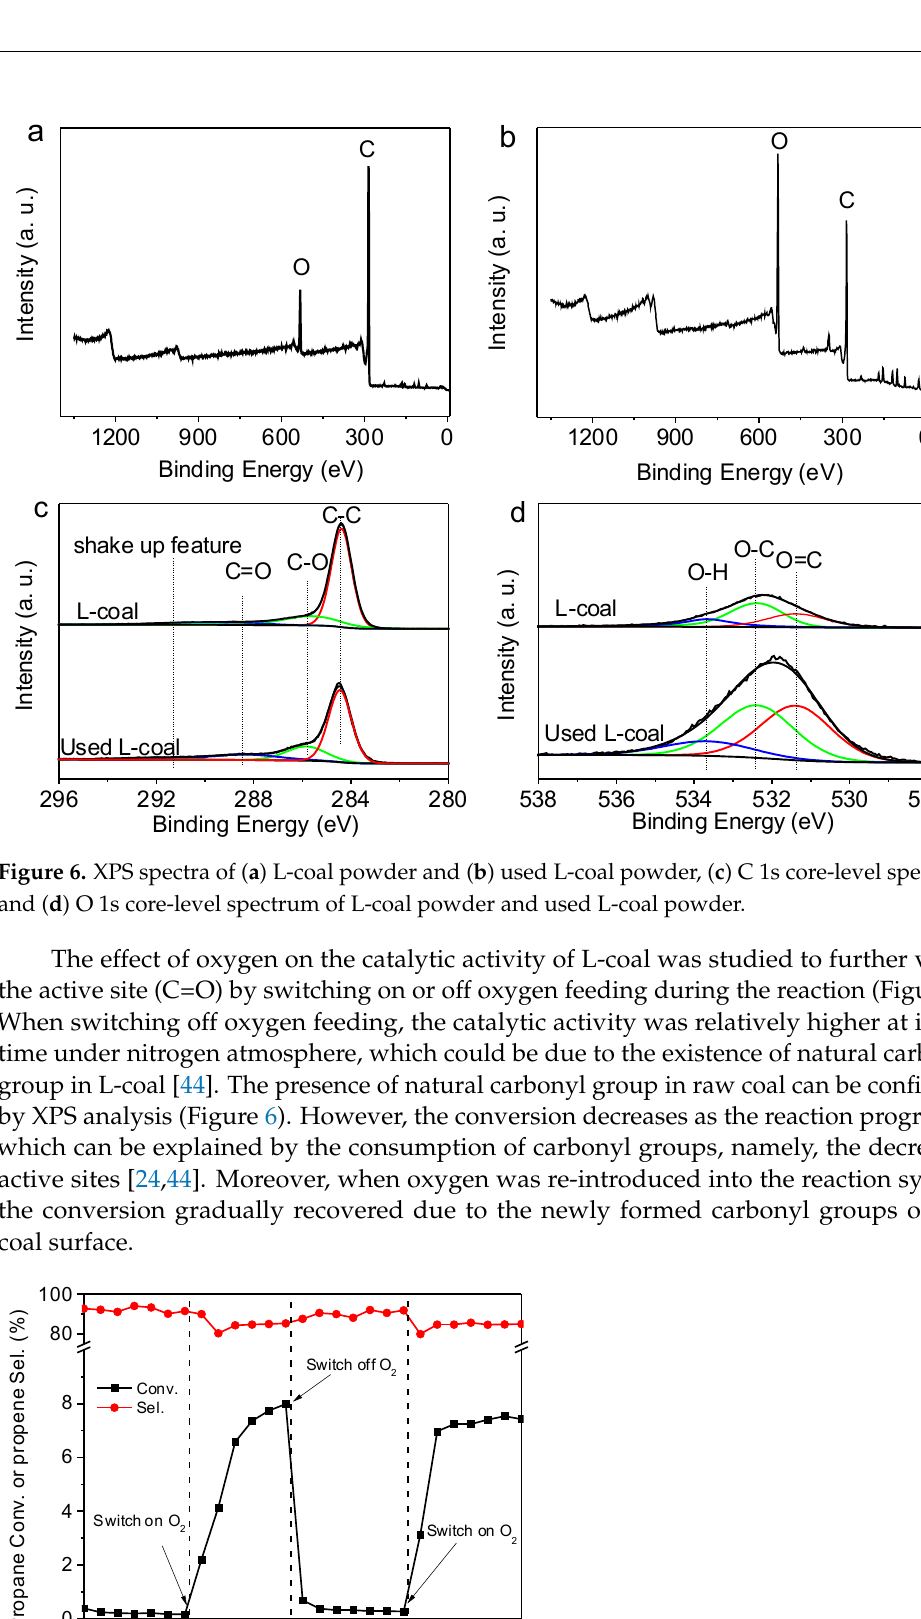
Figure 7. The e ff ect of oxygen on catalytic activity over L-coal by switching on or o ff oxygen feeding. Reaction conditions: 30 kPa C 3 H 8 , with or without 15 kPa O 2 , N 2 balance, mass space velocity 4000 mL·(h·g-cat) − 1 , 480 °C. 0.3 g catalyst, 20–40 mesh.